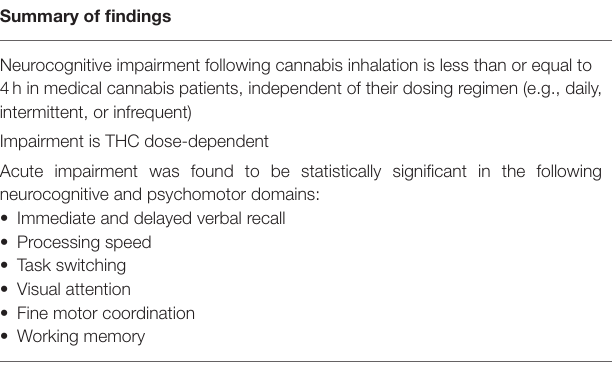
TABLE 5 | Summary of findings. Summary of